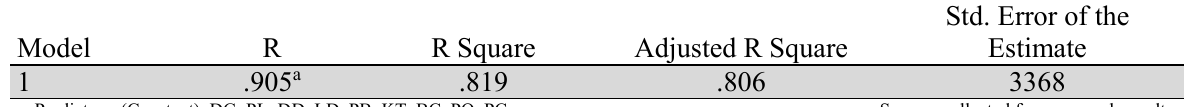
Model Summary R 2